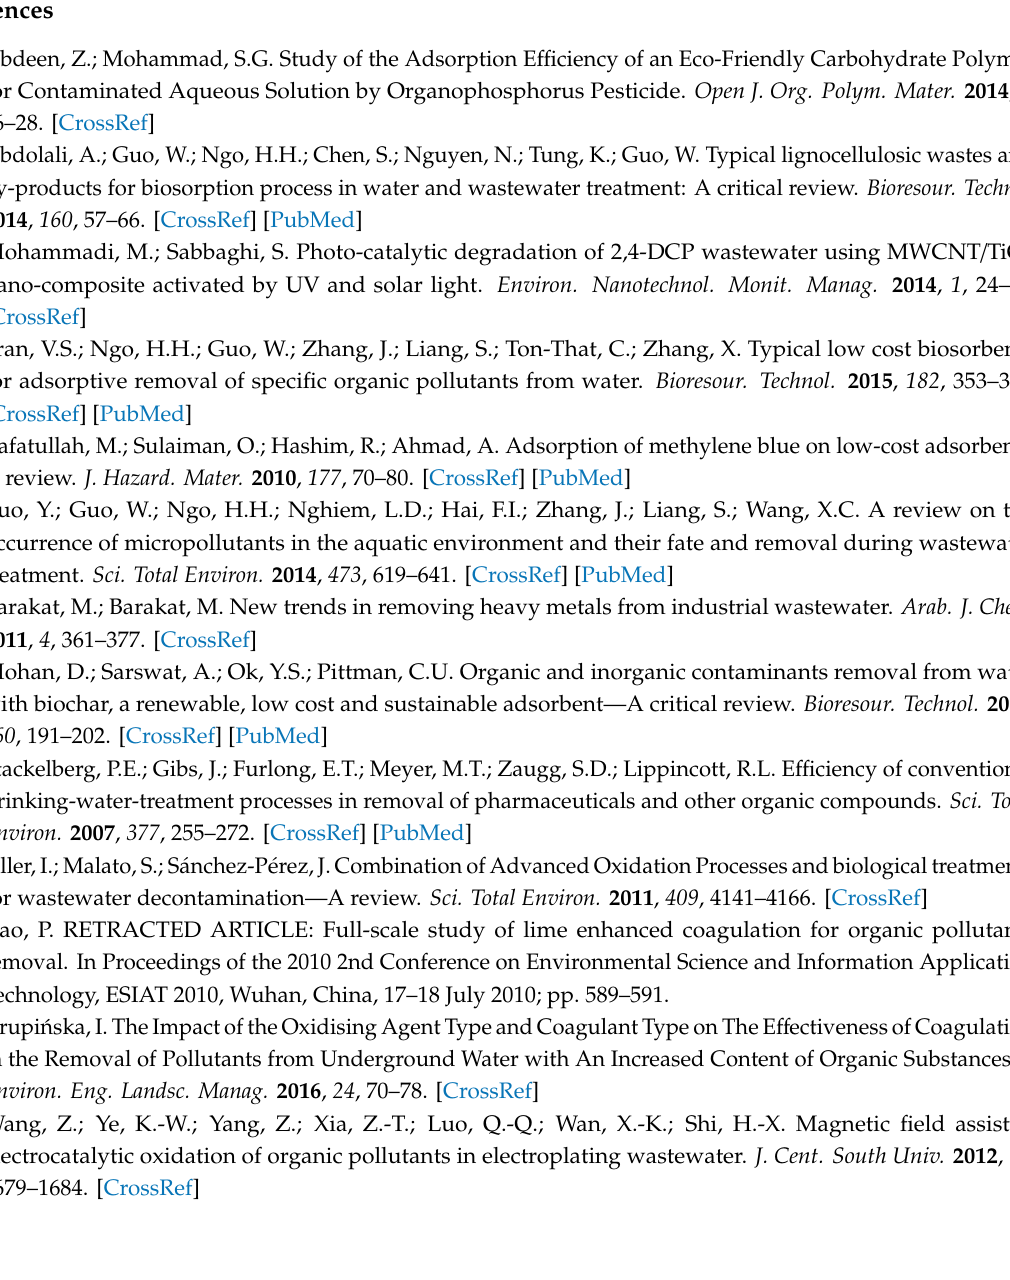
Figure S1: FE-SEM images of BN / PAN ES NFs with di ff erent spray coating time, the BN ES nanofiber membrane with the spray coating time. Figure S2: FE-SEM images of BN structure about the di ff erent ratio of the BN precursor, and the B 2 O 3 and CH 4 N 2 O were respectively mixed with di ff erent molar ratio. Figure S3: The EDX of pure PAN carbon NFs and BN-PAN composite ES NFs. Figure S4: The X-ray photoelectron spectra (XPS) of BN-PAN composite ES NFs. Figure S5: The removal e ffi ciency of the 3D BN NF membrane in Rh B aqueous solutions after 450 mins. Figure S6: The membrane can be recycled and reused for at least 10 times (the plot of the PL intensity vs time for the 10